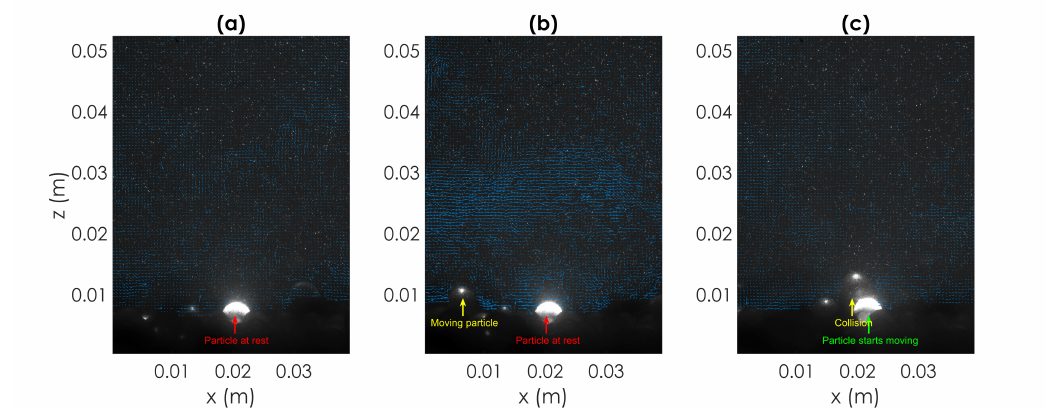
Figure 16. Particle entrained because of collective entrainment (Type C , Particle 27, Test T2). Sequence of three PIV images respectively showing (from ( a – c )): at time t = t 0 (2 time instants, corresponding to 0.1333 s, before entrainment) the bright particle located in the center of the image is at rest in the bed; at time t = t 0 + ∆ t (1 time instant, corresponding to 0.067 s, before entrainment) the particle is still at rest in the bed and another particle is approaching; at time t = t 0 + 2 ∆ t the travelling particle collides with the particle at rest; the bright particle starts its entrainment. (For clarity only 1 out of 2 vectors are depicted.)